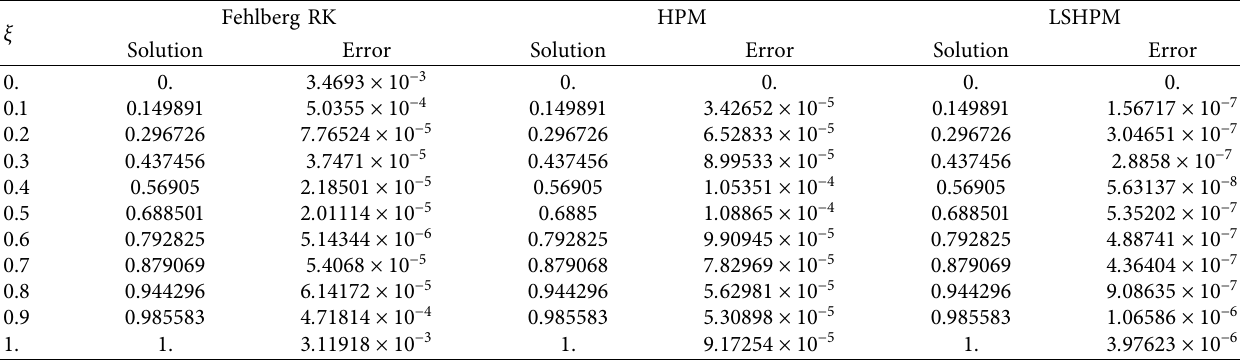
� 1 , and M � 0 . 7 in case of no slip. g p